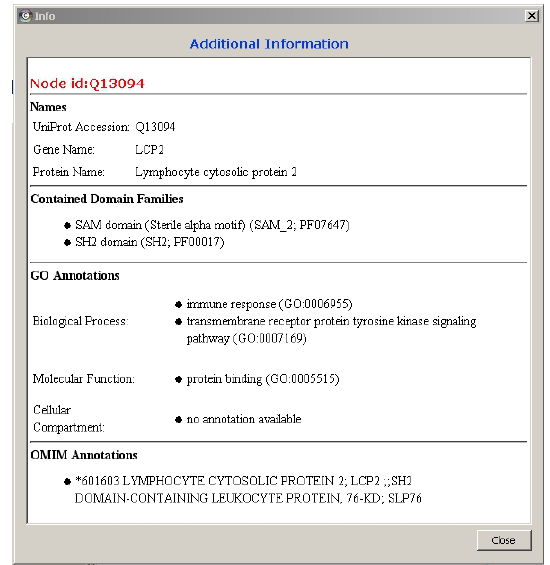
Figure 7: Textual information on the LCP2 protein, concerning the protein and constituent do- mains and the Gene Ontology (GO) and OMIM disease